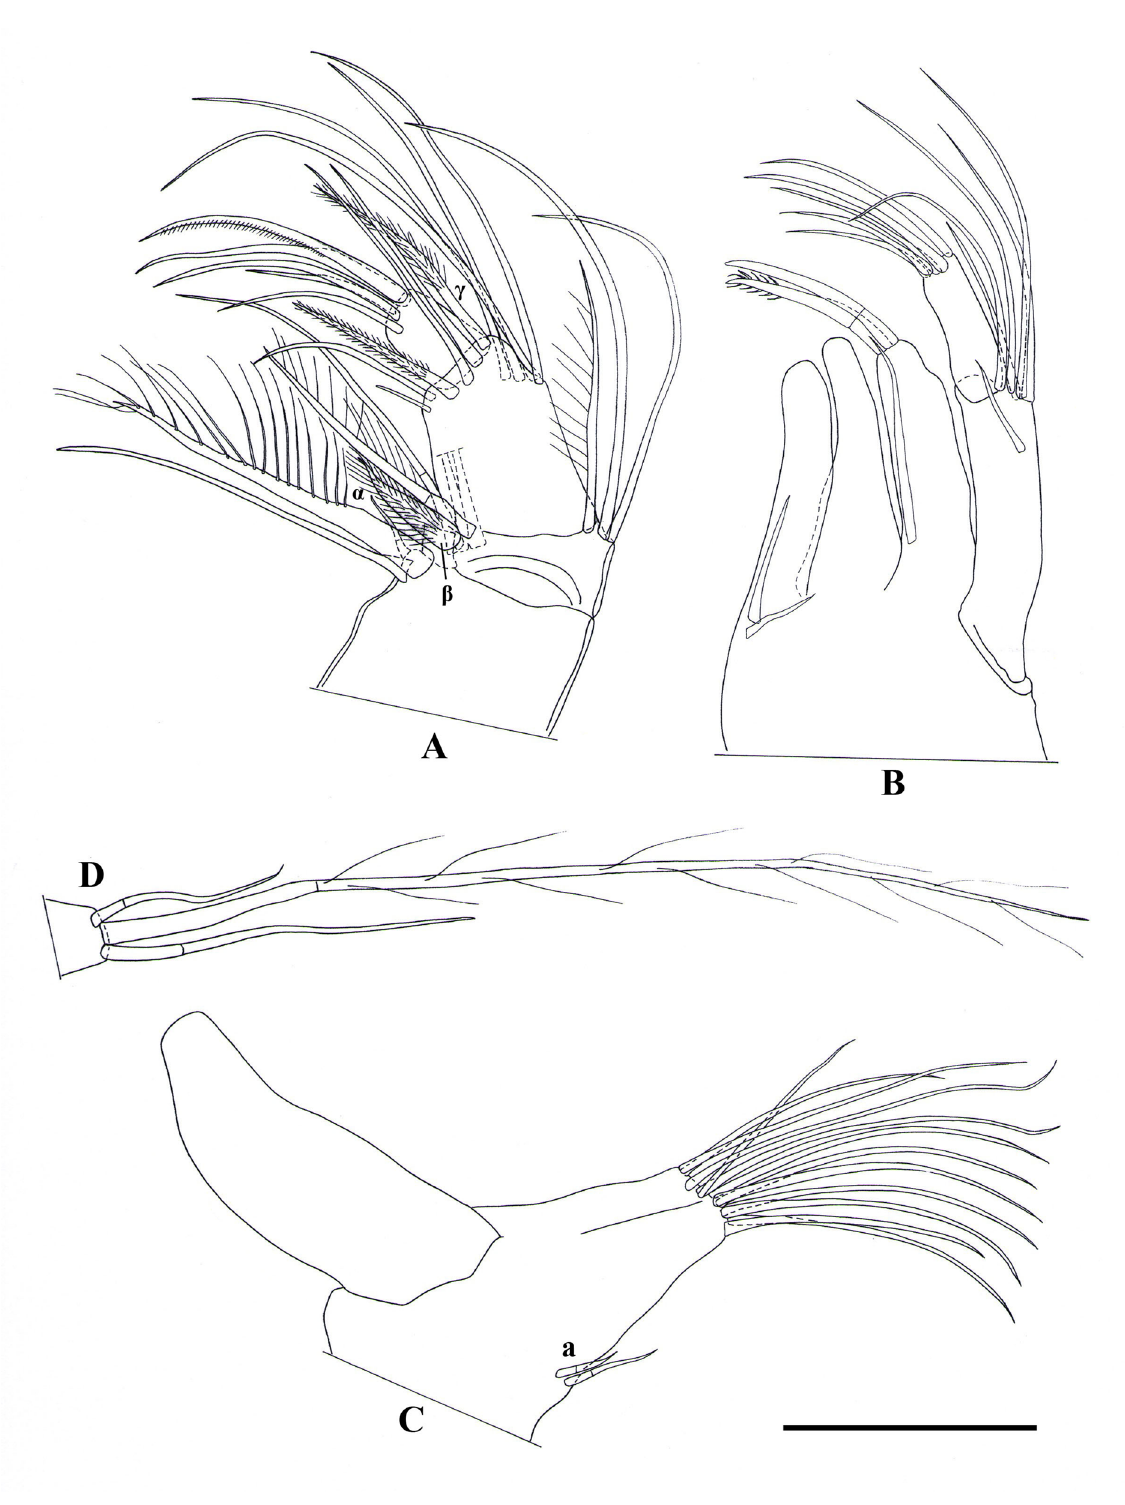
Fig. 3. Siamopsis renateae gen. et sp. nov., ♀ (MSU-ZOC.190). A . Md palp. B . Mx1. C . T1. D . T1, terminal part of endopodite. Scale bar: 50